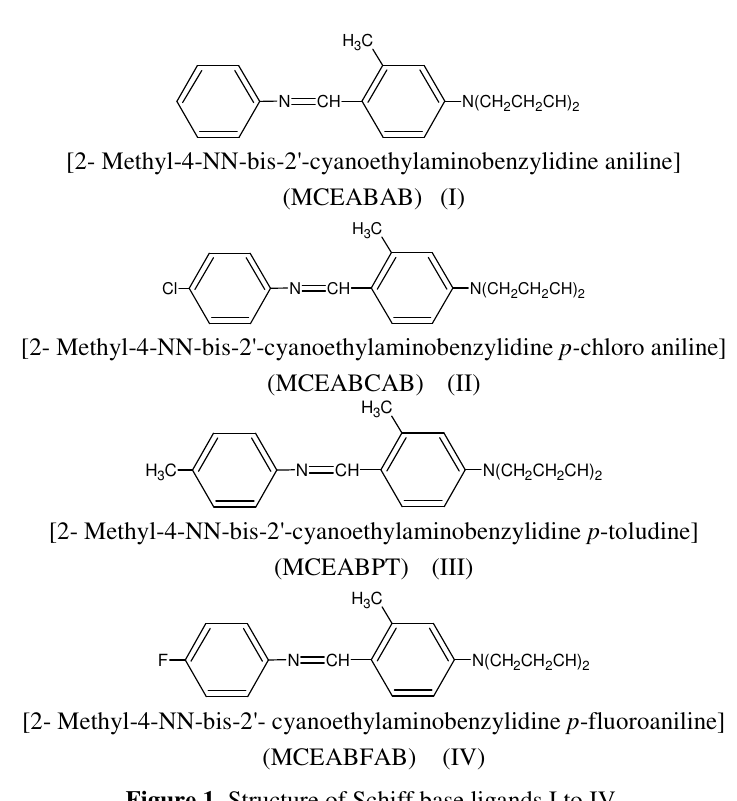
Figure 1. Structure of Schiff base ligands I to